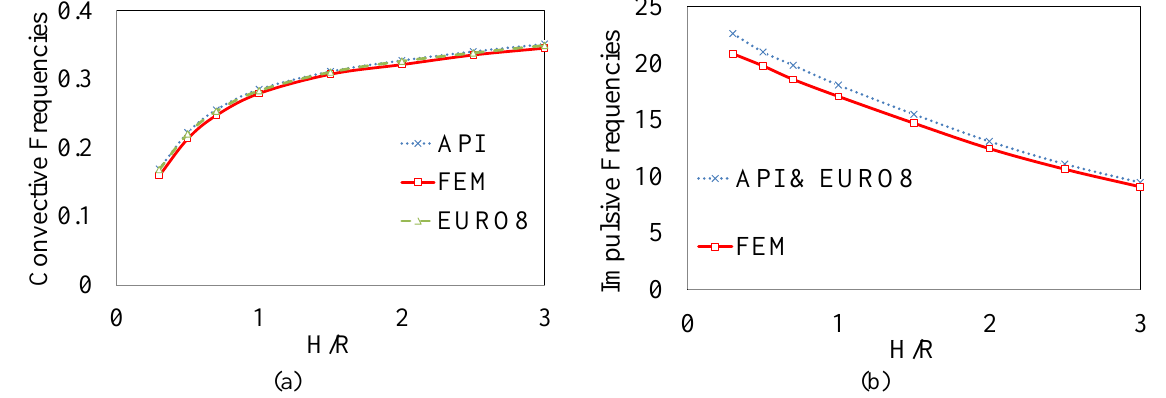
Fig. 5. Comparison of the effect of ( H/R ) on frequencies (Hz); a) convective; b) impulsive Table 7. Comparing of impulsive and convective frequencies (effect of ( H/R )) Tank H/R